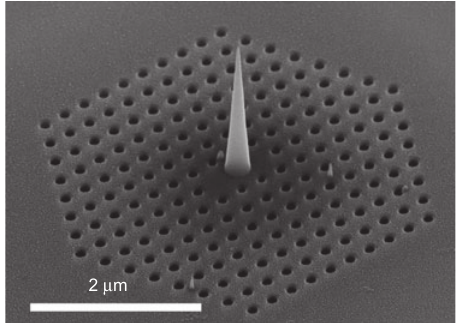
Figure 19 Tapered conical silver-coated EBID grown tip at the center of a photonic crystal cavity. Reprinted with permission from